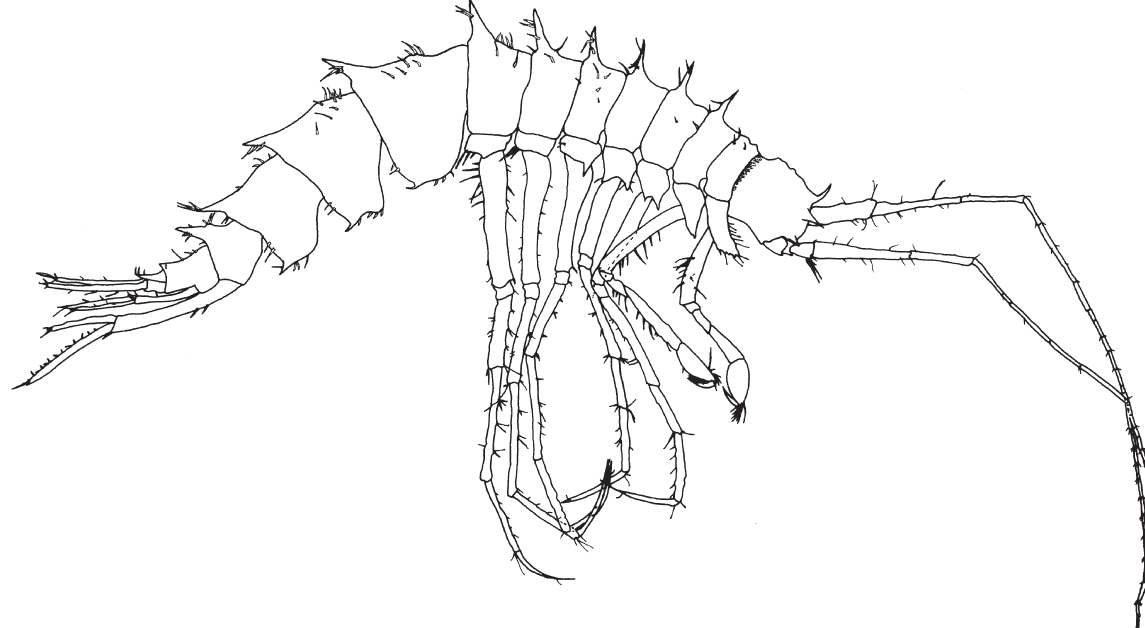
Fig . 1. – Lepechinella campensis n. sp., holotype, sex unknown, 5.7 mm, MnrJ17384, oceanprof i #45, 22°10’54.4”S to